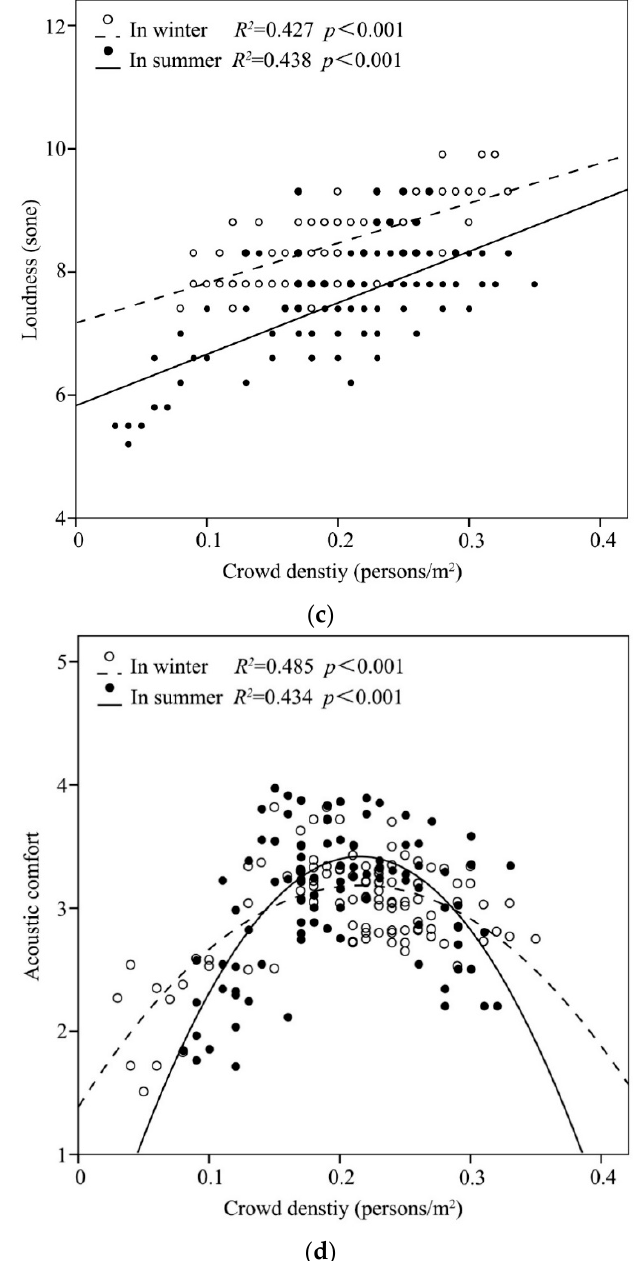
Figure 8. The influence of the season: ( a ) the relationship between crowd density and the number of talkers; ( b ) the relationship between crowd density and the level of sound pressure; ( c ) the relationship between crowd density and loudness; ( d ) the relationship between crowd density and acoustic comfort.